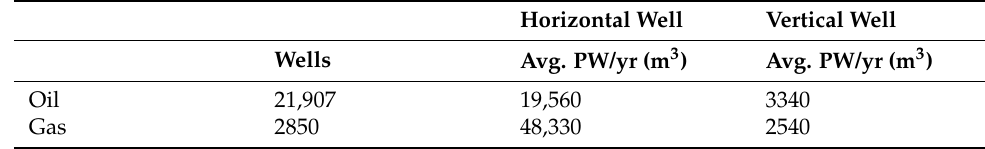
Table 1. Average annual PW volume per well for oil and gas wells in southeastern New Mexico in 2019.